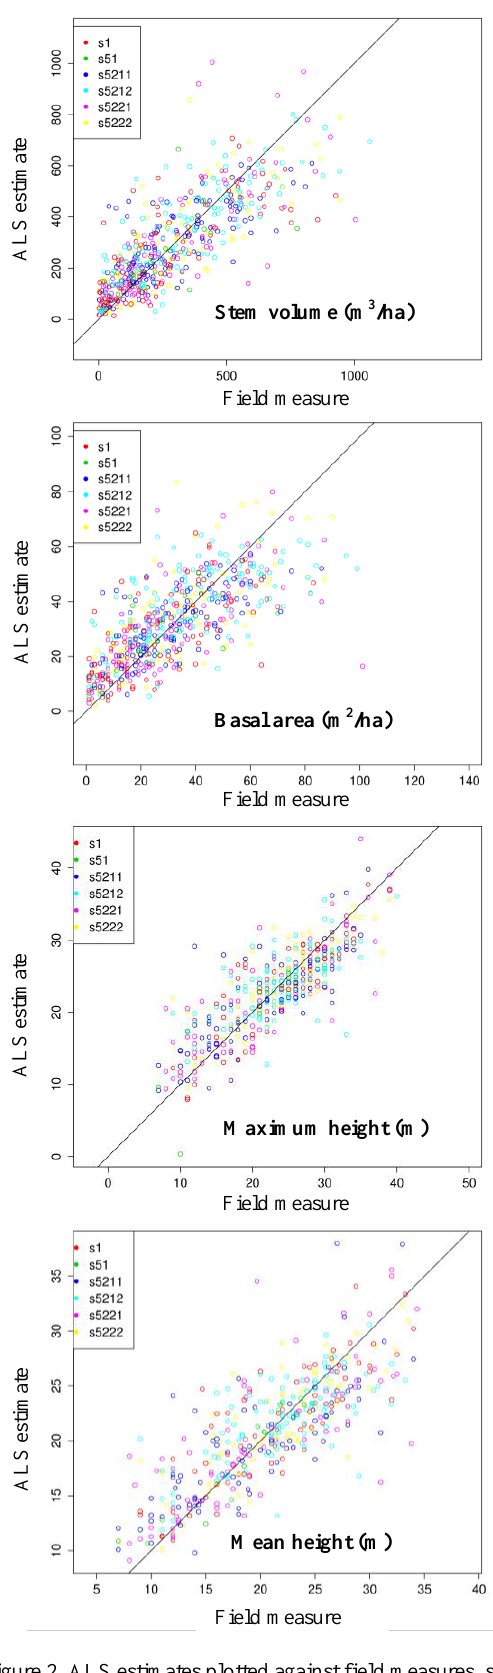
Figure 2. ALS estimates plotted against field measures, symbol color refers to the different